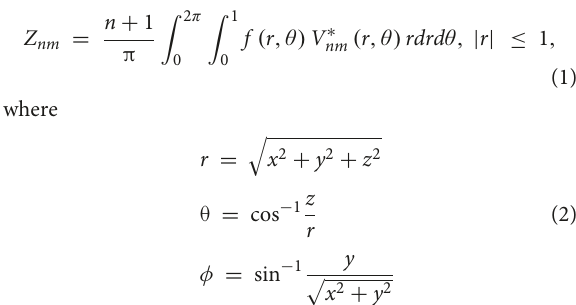
B . Every point ( x , y , z ) in the unit ball B can